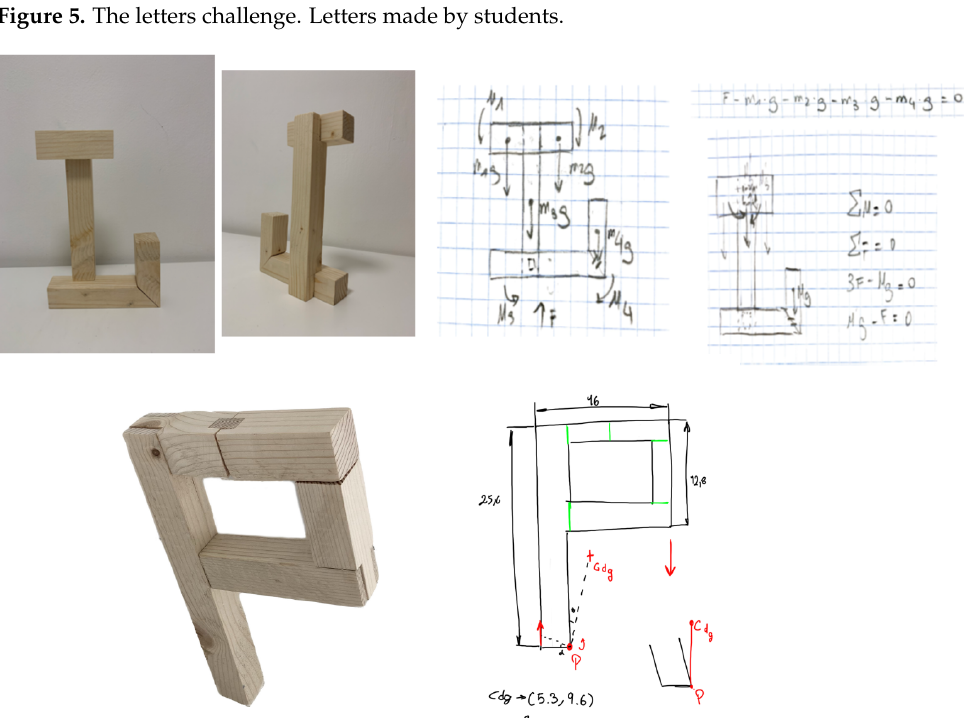
Figure 6. The letters challenge. Examples of results and